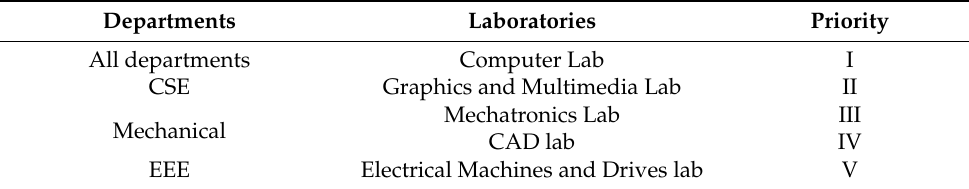
Table 4. End-user priority for Laboratories.